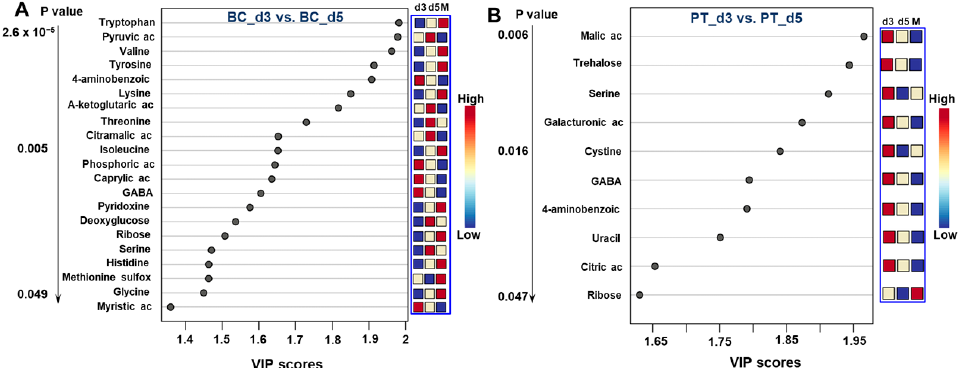
Figure 6. Metabolites discriminating on Days 3 and 5 in both culture modes. Conditions based on VIP scores (variable importance in projection) from OPLS-DA and the corresponding detection intensity measured on each day of culture: ( A ) biochip culture and ( B ) Petri culture. The blue box represents the levels of metabolites in Petri (PT) and biochip (BC) on Days 3 and 5 compared to the initial culture medium (M). OPLS-DA: orthogonal projections to latent structures-discriminant analysis; BC_d3 and BC_d5: biochip cultures after 3 and 5 days; PT_d3 and PT_d5: Petri cultures after 3 and 5 days.